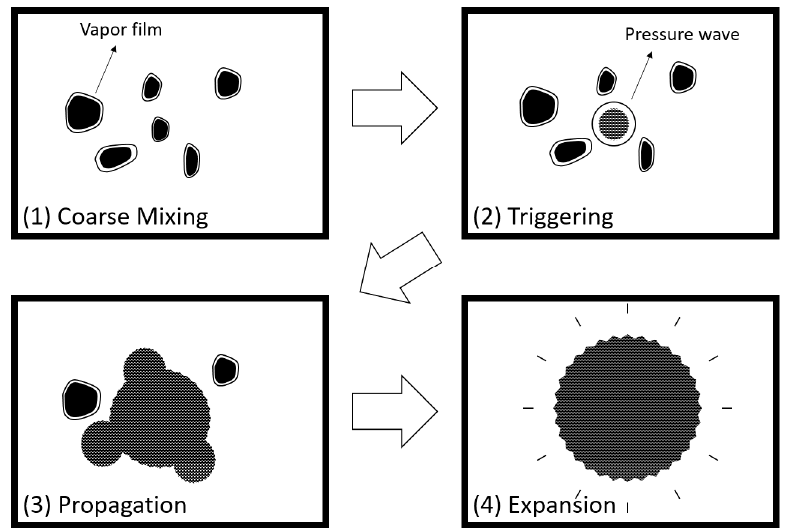
Figure 1. Schematic overview of the steps by which a vapor explosion occurs (adapted from Refer- ence [22]).